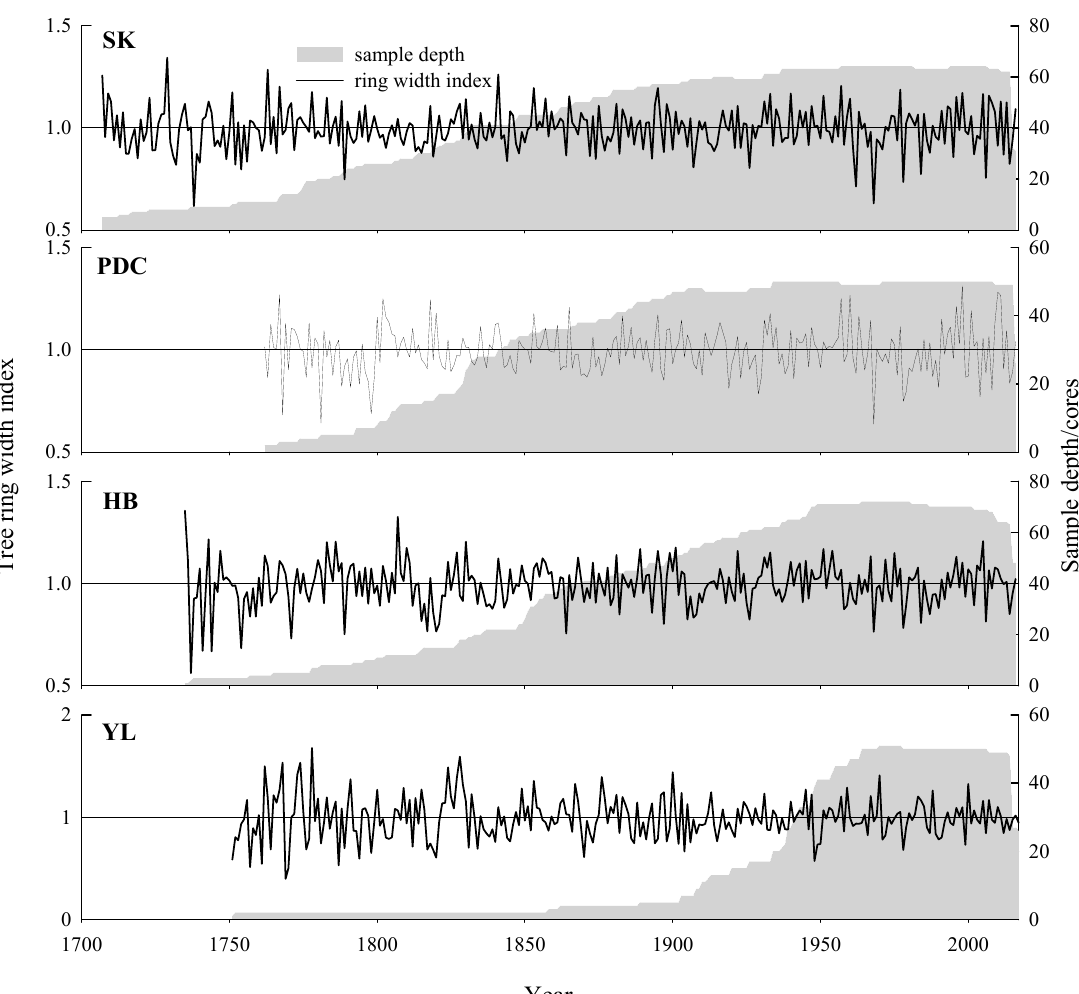
Figure 4. Residual tree ring width chronologies of Abies georgei at four sites with an annual variation in ring width index (black line), and sample depth (gray shading).